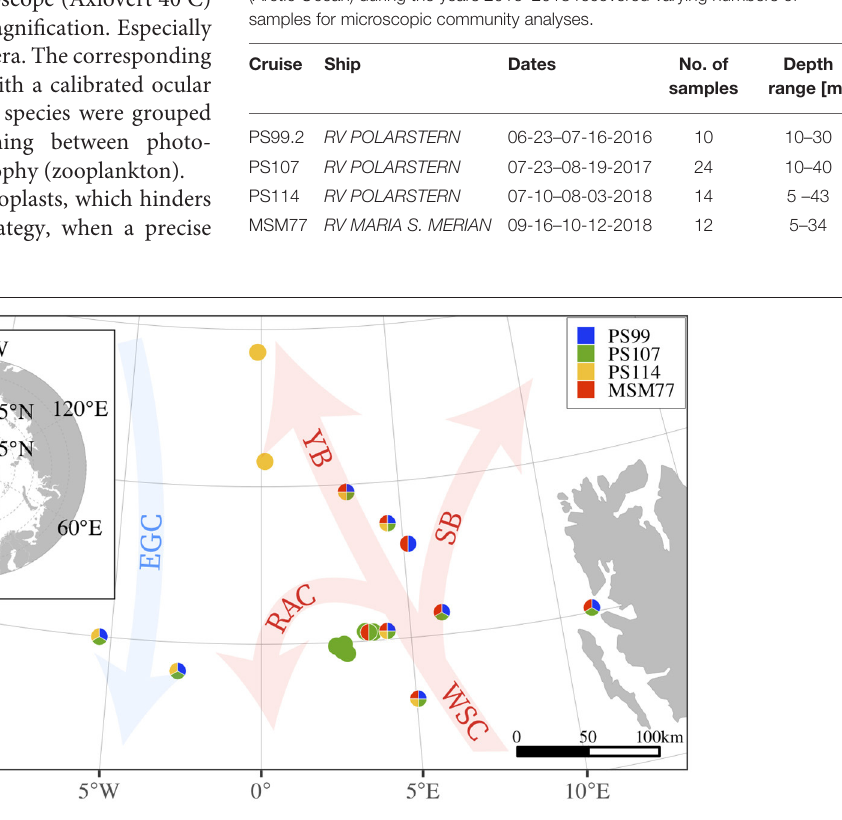
FIGURE 1 | Location of the sampling site in the Fram Strait. Sampling stations are shown as dots, color-coded by the respective campaigns ( Table 1 shows sampling time and depth ranges). Arrows show the main currents from the North-Atlantic (warm, red; WSC, West-Spitsbergen Current; RAC, Return Atlantic Current; YB, Yermak Branch; SB, Svalbard Branch) and the Arctic Ocean (cold, blue; EGC: East-Greenland Current), after Soltwedel et al. (2016).